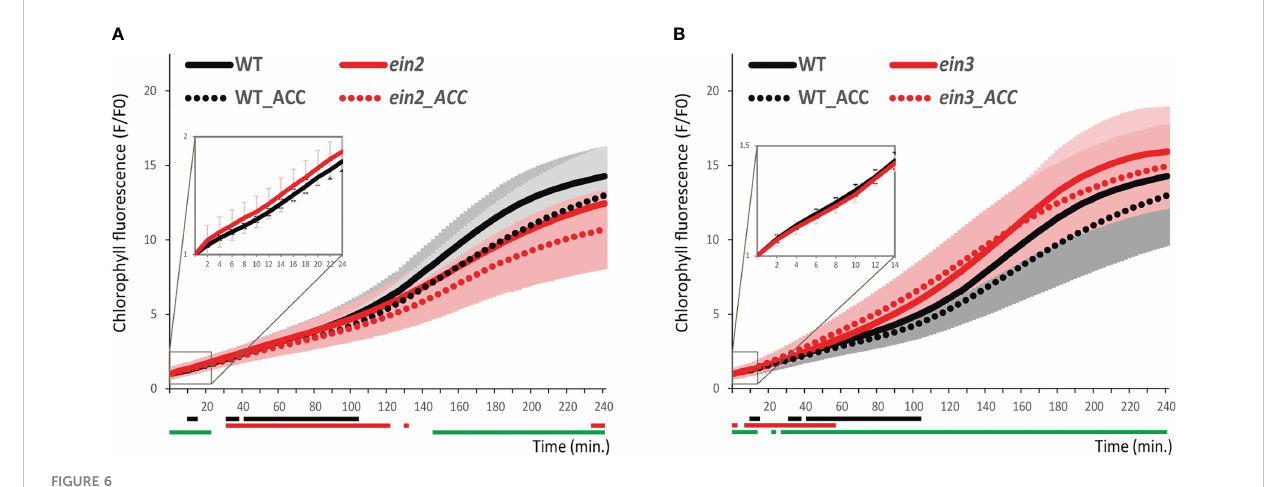
FIGURE 6 Chlorophyll kinetics in wild-type and ethylene-insensitive mutants. Chlorophyll accumulation in 4-days-old etiolated seedlings in WT Col-0 compared to (A) ein2 and (B) ein3 . Data represent the mean values ± SD, n=9 of raw data ( fl uorescence F) normalized to the mean fl uorescence value at T0 (F0). Lines under the x axis (black for wild-type and red for mutant) indicate the time intervals with signi fi cantly different values (P<0.05) comparing non-treated and ACC-treated genotypes. The green lines under the x axis depict the signi fi cantly different values (P<0.05) the corresponding time intervals between mock-treated WT and mutant